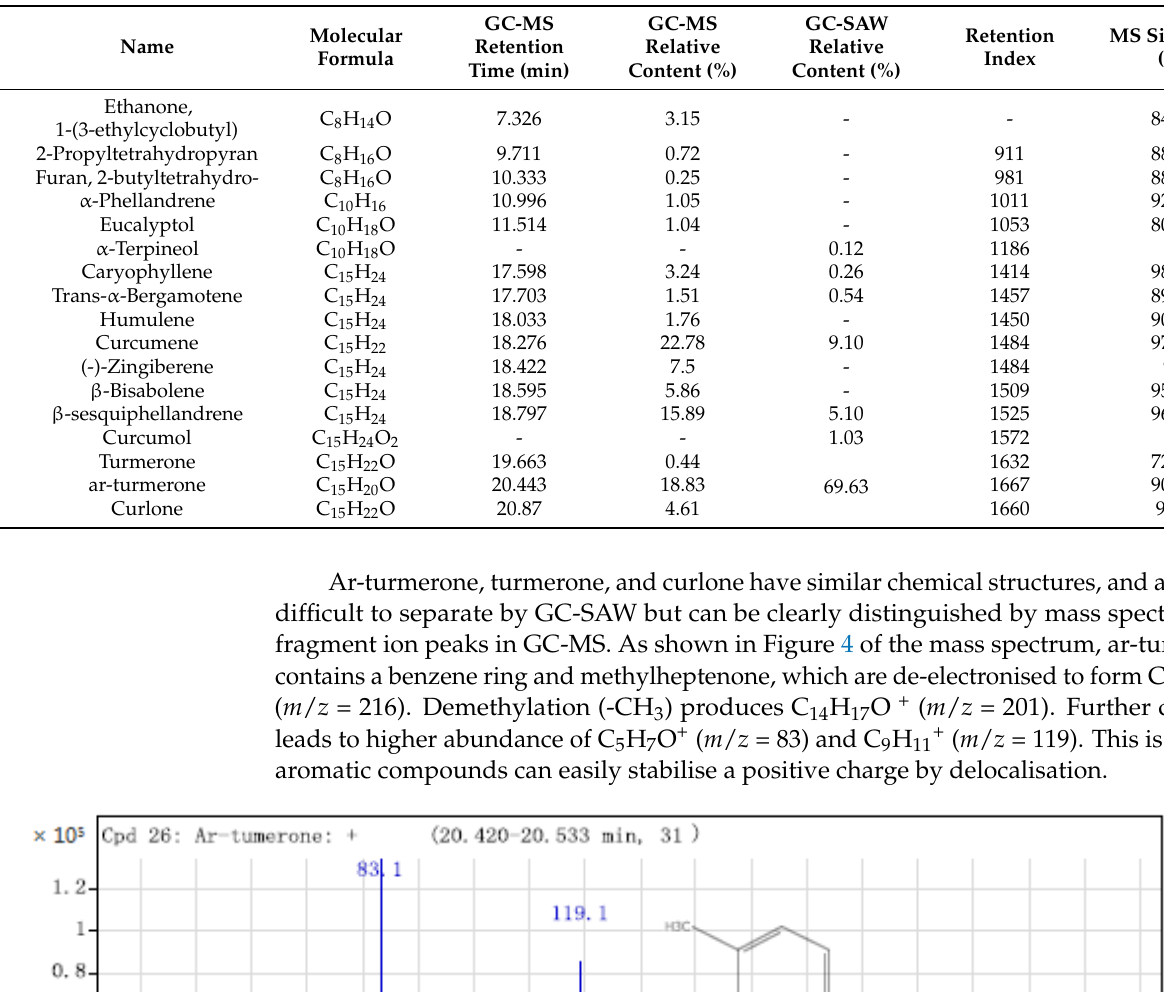
Table 2. GC-MS and GC-SAW test data comparison of turmeric.